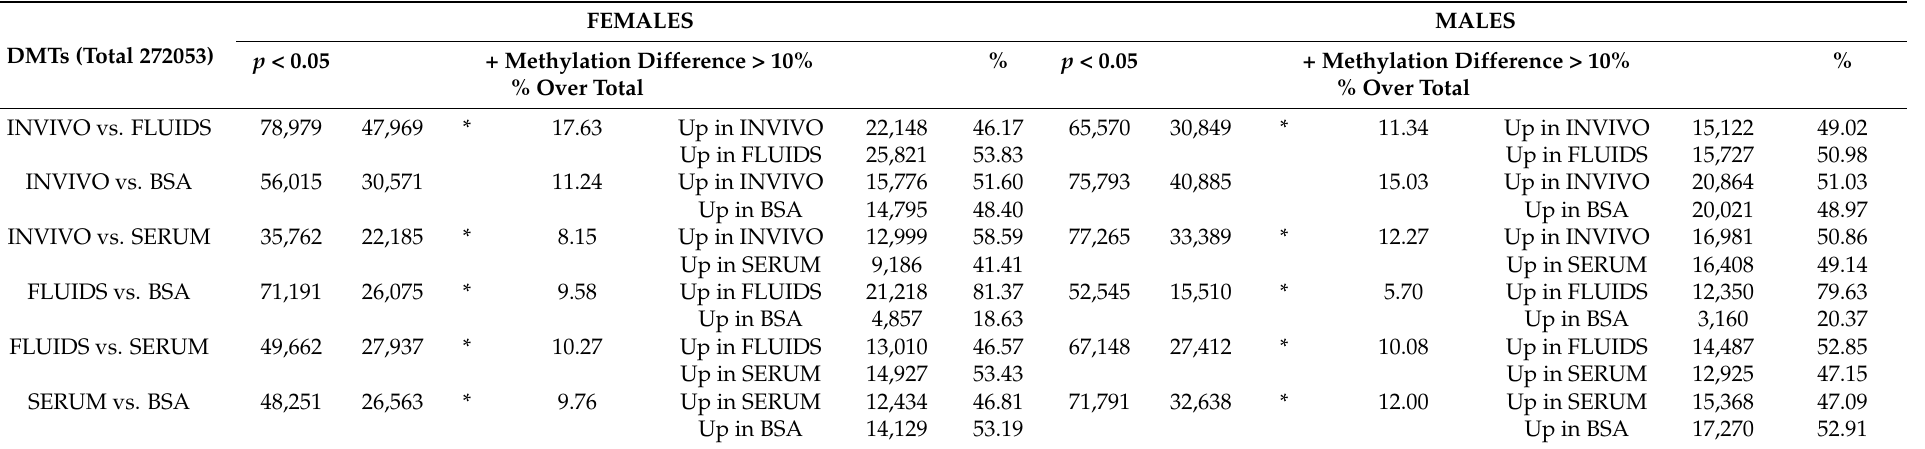
Table 3. DMTs were calculated by logistic regression ( p < 0.05) for each pairwise comparison. From these DMTs, tiles with methylation differences over 10% were selected and split in tiles with increased methylation for each group.